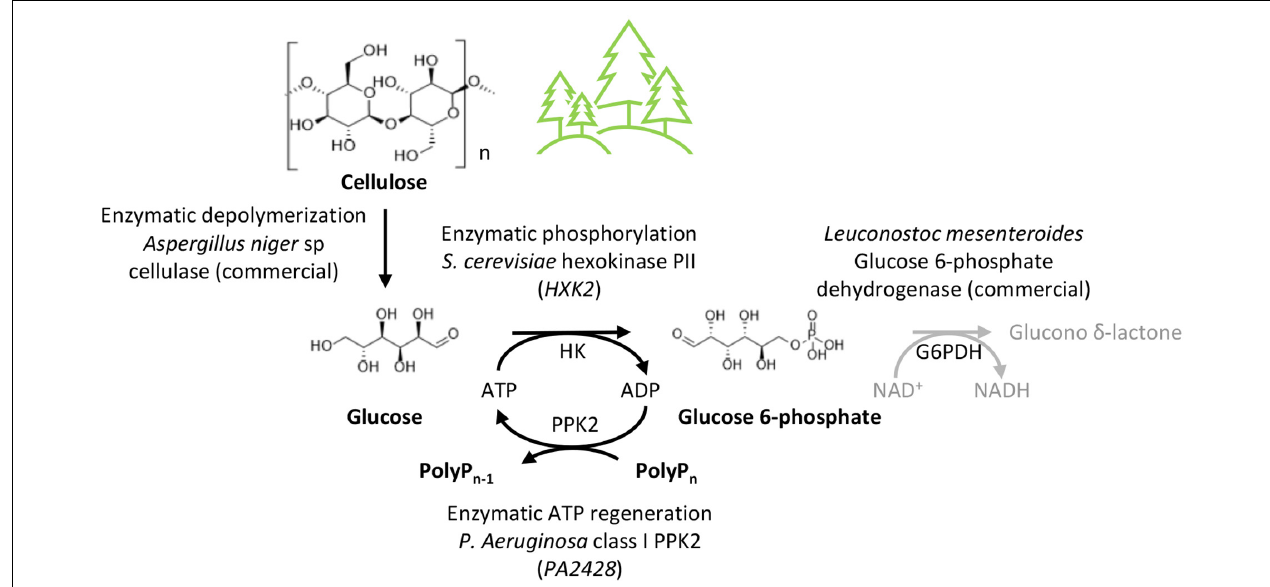
FIGURE 6 | Conversion of cellulose into value-added products. Overall reaction scheme for the one-pot production of glucose 6-phosphate from cellulose. The glucose 6-phosphate dehydrogenase (G6PDH) reaction could be integrated into the reaction scheme for conversion into 6-phospho-D-glucono-1,5-lactone. Various other metabolites can be derived from glucose